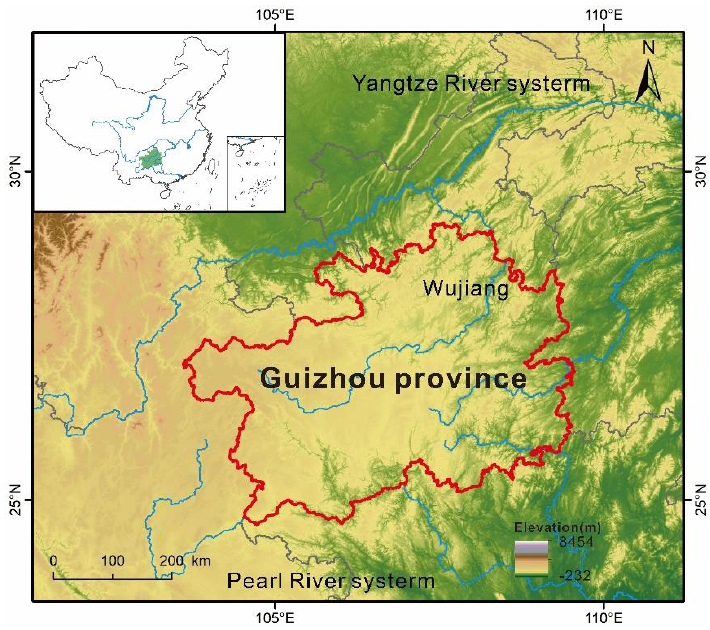
Figure 1. Location of the study area.